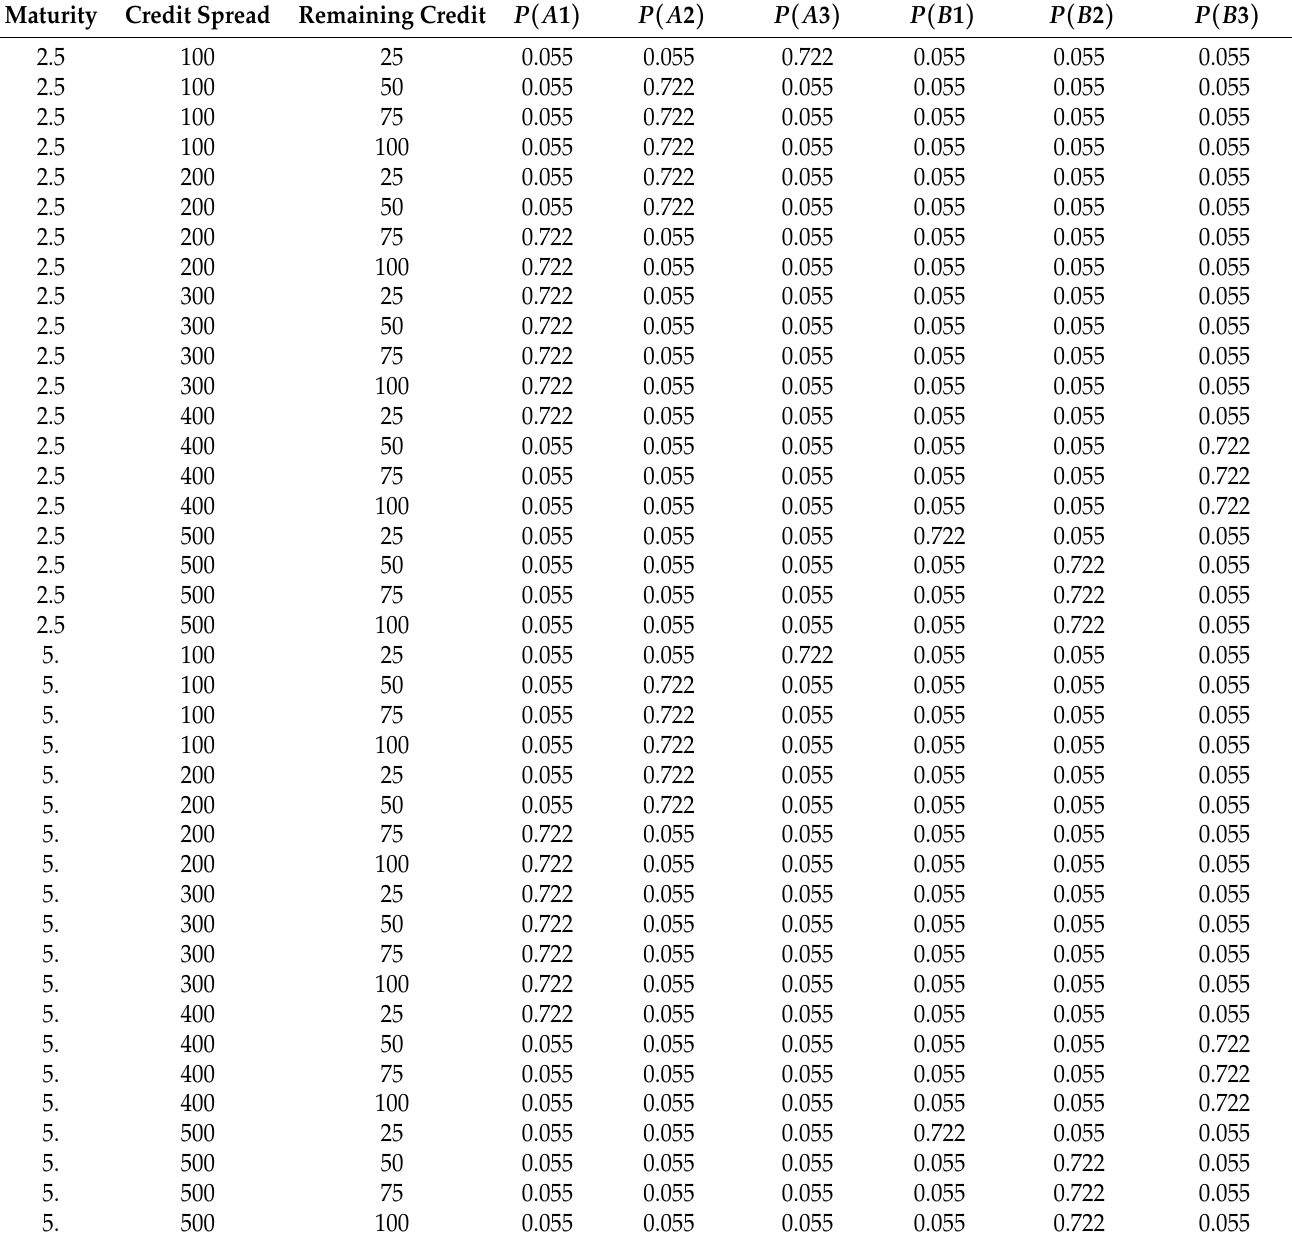
Table 4. Probabilities of belonging to each ranking categories by varying the three features under the discussed ML model.